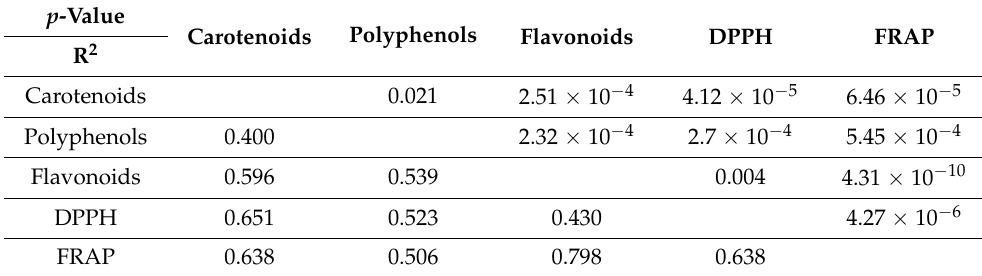
Figure 3. Principal component analysis (PCA) performed on the dataset for dry microalgal biomass ( A ) and fresh microalgal cultures ( B ), respectively. Table 2. Pearson correlation analysis performed on carotenoids, polyphenols, flavonoids, FRAP, and DPPH data of dry microalgal